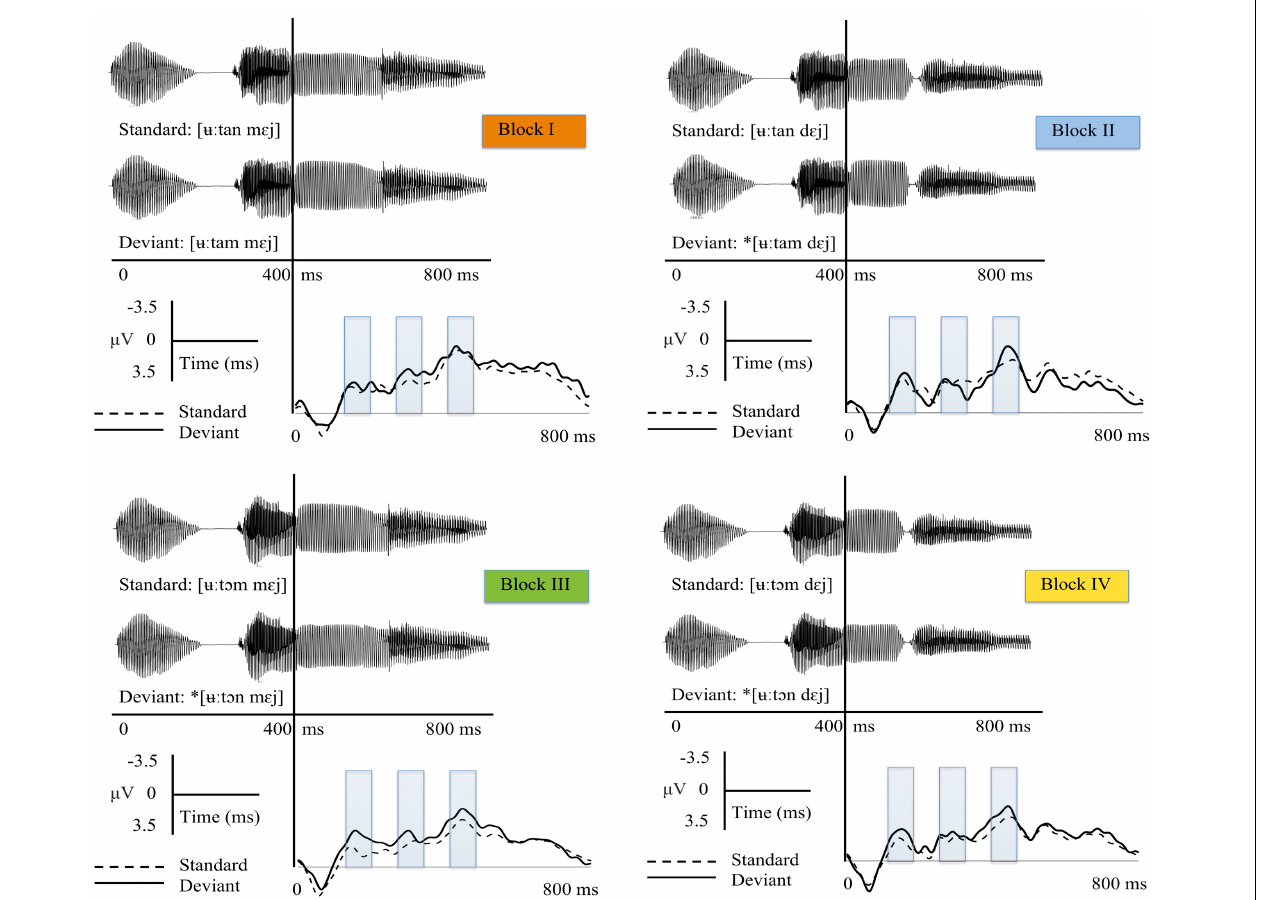
FIGURE 1 | Sound and grand-average ERP waveforms (from Fz) for the standard and deviant stimuli in each block. Blocks are color-coded in line with the bar graphs presented in Figure 2 . The black lines show the ERPs for the deviant stimuli, the dashed lines the ERPs for the standard stimuli. The divergence point was used as zero point in the ERP figures given that the standards and deviants were identical up to the assimilation point. The shaded bars represent time windows selected for statistical analysis. Asterisks mark inappropriate/unattested deviant sequences.